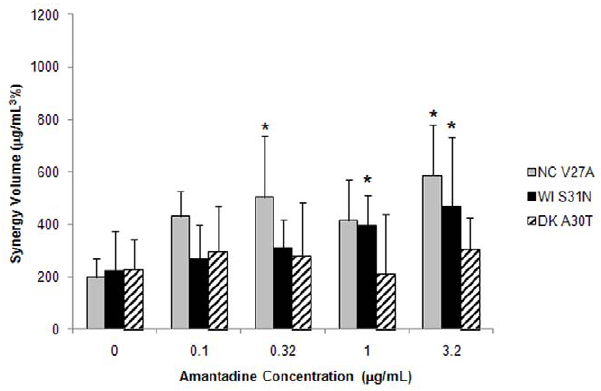
Figure 2. Synergy of the TCAD regimen against seasonal and avian amantadine-resistant viruses. Amantadine-resistant seasonal and avian viruses were incubated with MDCK cells in the presence of drugs, and CPE was determined by Neutral Red assay. Synergy volumes are plotted as a function of amantadine concentration, with 0 m g/mL amantadine being the ribavirin/oseltamivir carboxylate double combi- nation. Gray bars, A/New Caledonia/20/99 (H1N1) V27A (NC V27A); black bars, A/Wisconsin/67/05 (H3N2) S31N (WI S31N); hatched bars, A/ Duck/MN/1525/81 (H5N1) A30T (DK A30T). Data are presented as the mean between 10 replicates from 4 experiments with 95% confidence intervals for NC V27A, 27 replicates from 9 experiments with 95% confidence intervals for WI S31N, and 12 replicates from 4 experiments with 95% confidence intervals for DK A30T. The concentrations of each drug used in double and triple combinations are provided in Table S1.